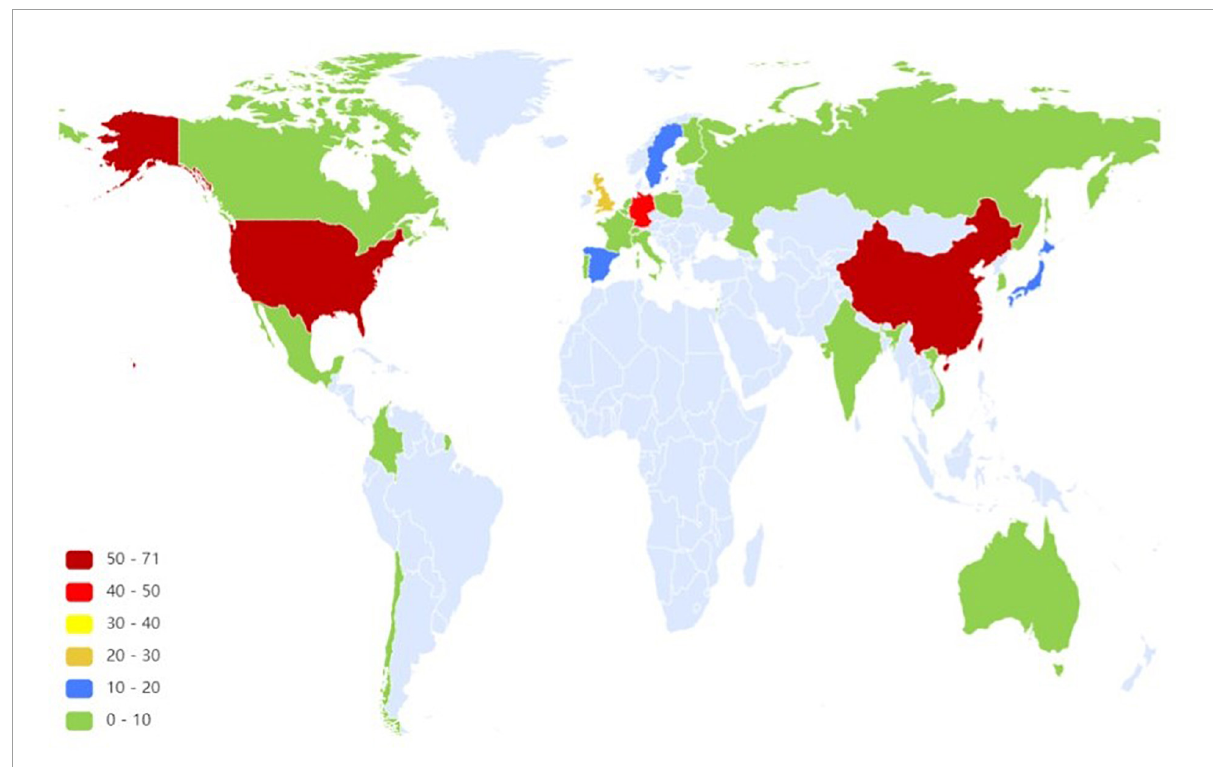
FIGURE6 Geographical distribution of publications. The light blue area means that the number of publications is 0.